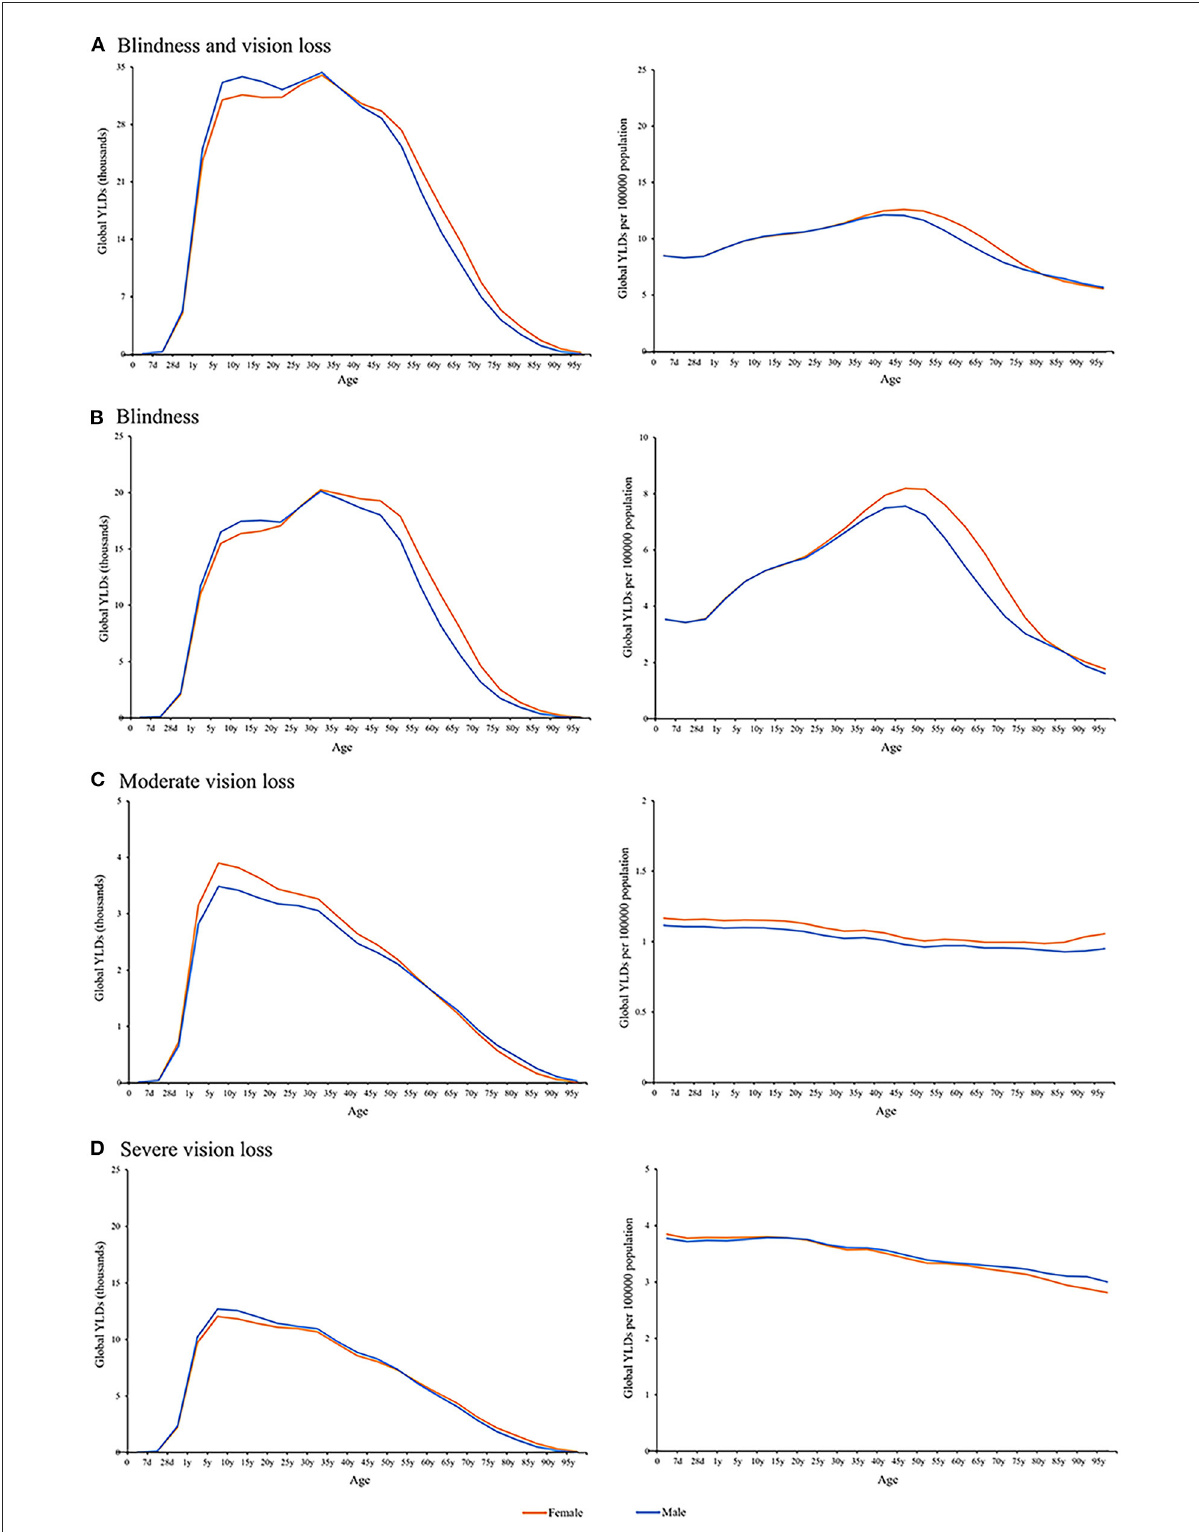
FIGURE3 Global sex-specific NPB-related vision impairment burden by age in 2019. Sex disparities in the global burden of (A) NPB-related blindness and vision loss, (B) NPB-related blindness, (C) NPB-related moderate vision loss, and (D) NPB-related severe vision loss by age group in 2019, as measured by YLD numbers and crude YLD rates. NPB, Neonatal preterm birth; YLDs, years lived with disability; blue line, male; orange line,